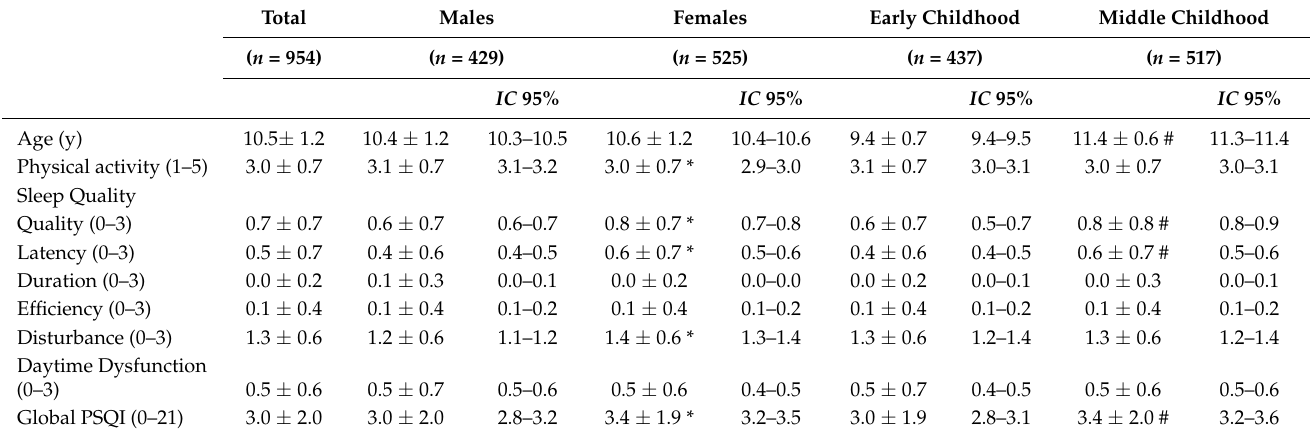
Table 1. Comparative values of physical activity levels and sleep quality according to sex and maturational